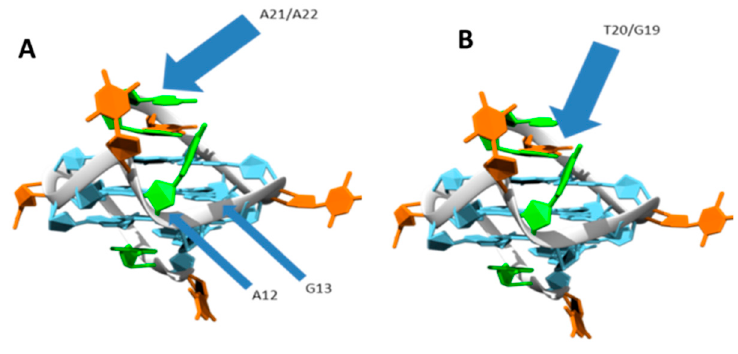
Figure 5. A schematic representation of the platination sites for ( A ) Pt-ttpy and ( B ) Pt-BisQ on c-myc G4. The platination sites are in indicated in bold .